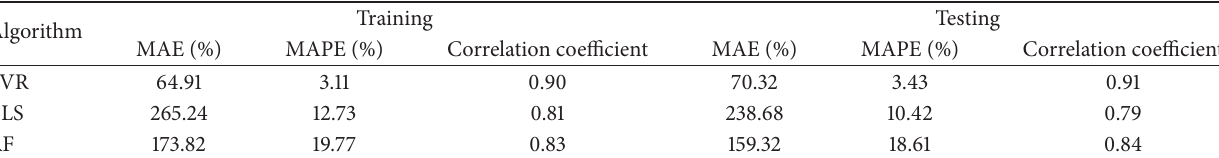
Table 3: Performance results for one week.